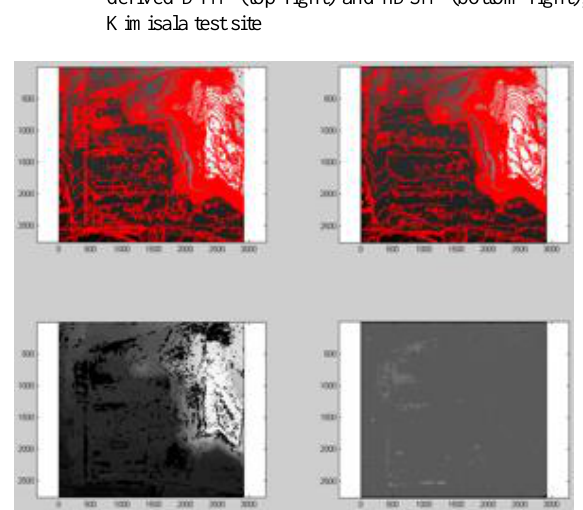
Table 2:Statistics of errors on reference points, collected during the UAV expedition in the 2 test sites,